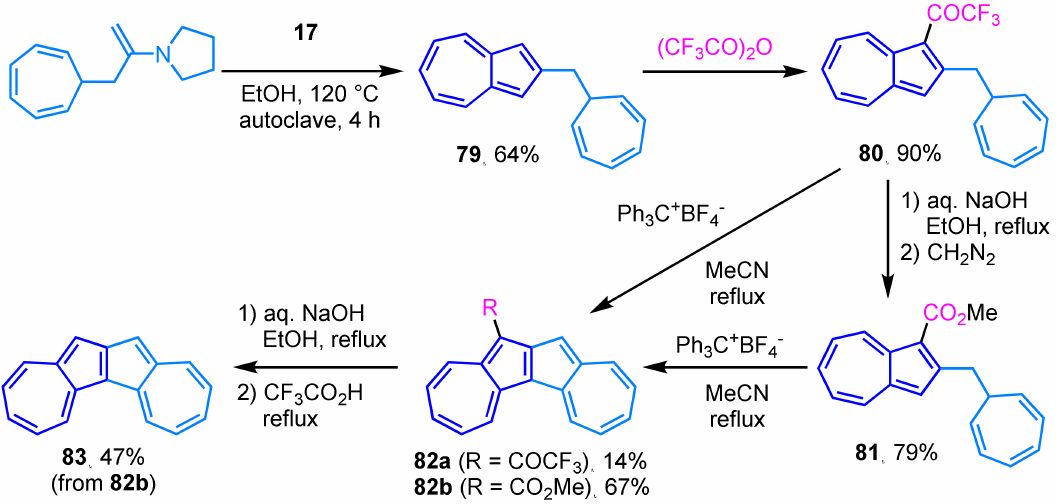
Scheme 24. Synthesis of azuleno[1,2- a ]azulenes 82a , b and 83